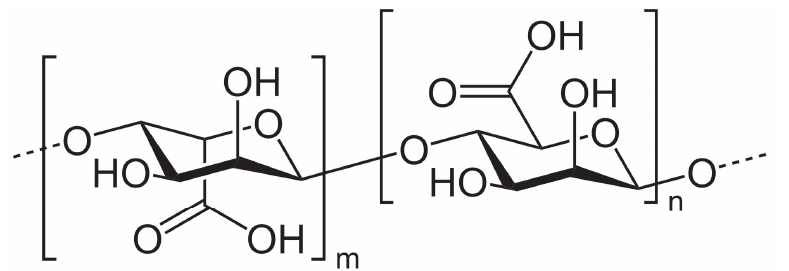
Figure 10. Chemical structure of alginic